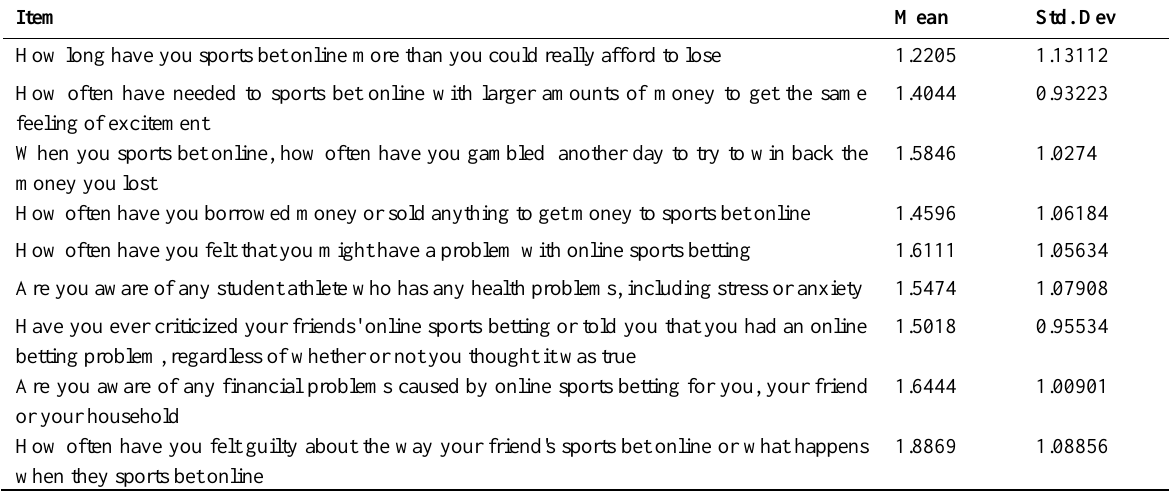
Table 2: Descriptive results- gambling